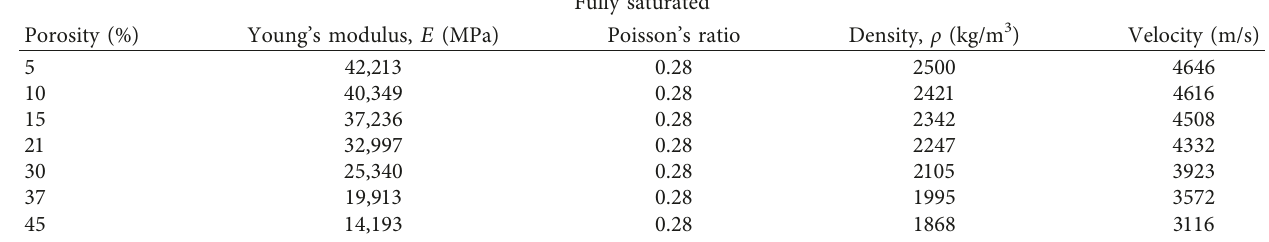
Table 6: Results for simulating different porosities under fully saturated situation. Fully saturated